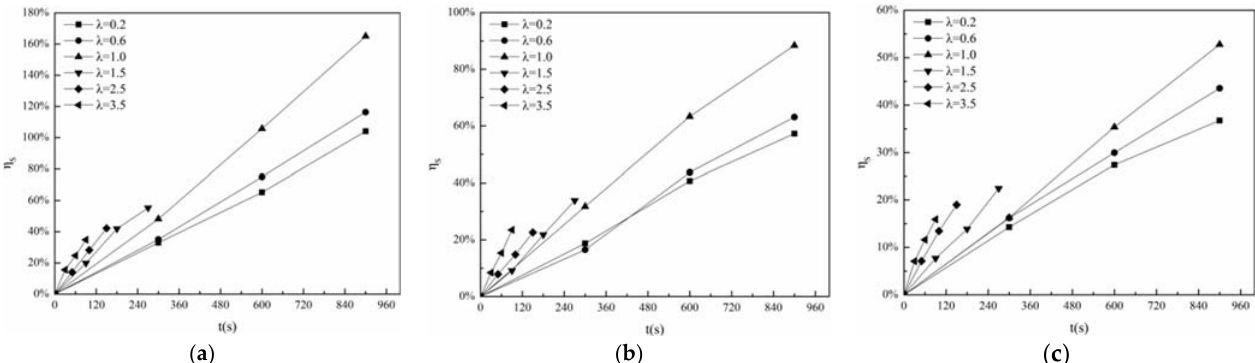
Figure 10. Dimensionless icing areas of the rotating cylinders with different diameters: ( a ) d = 20 mm; ( b ) d = 30 mm; ( c ) d = 40 mm.